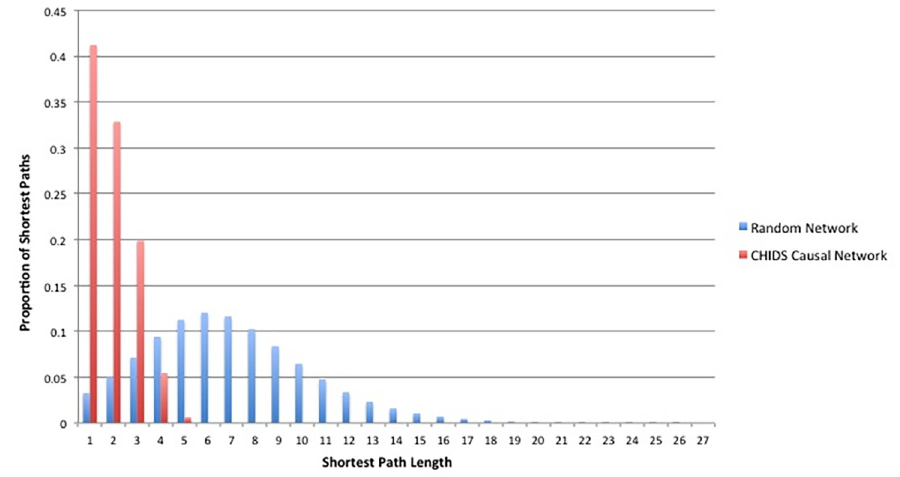
Fig 4. Distribution of Shortest Paths in the CHIDS Network and the Random